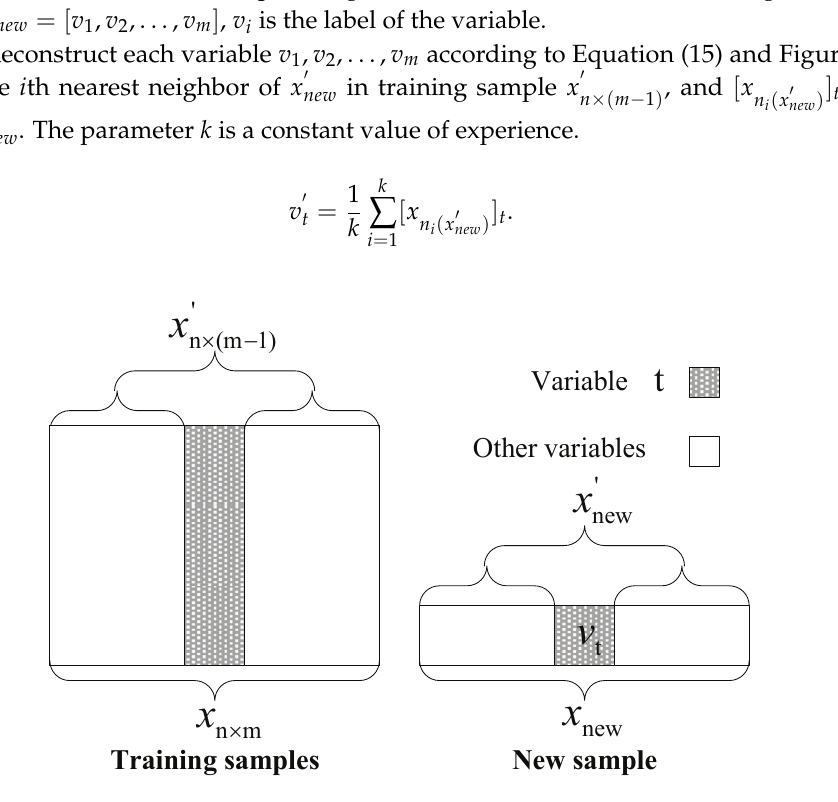
Figure 2. Flowchart of variable restructuring